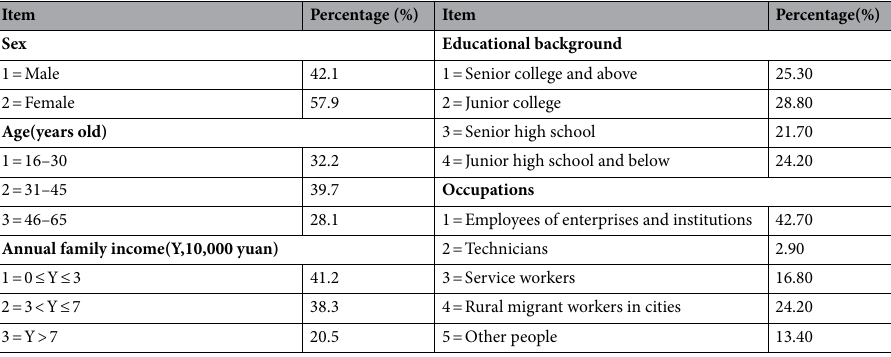
Table 2. Basic information about respondents. Data source: